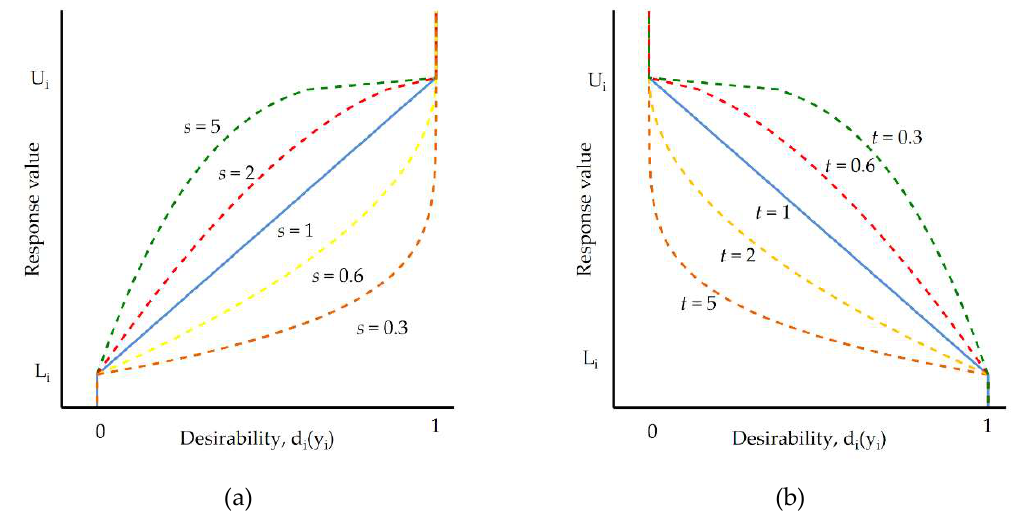
Figure 17. The desirability functions for the target value: ( a ) maximized; ( b ) minimized criteria.